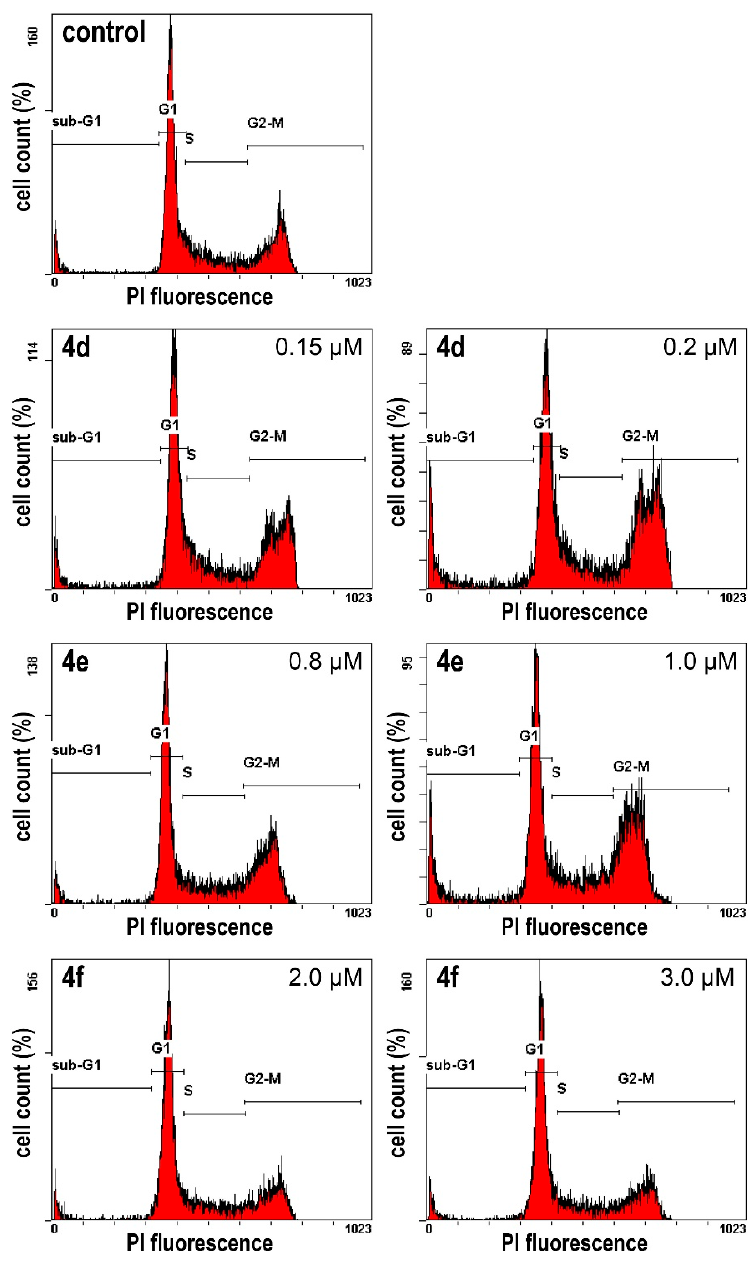
Figure 6. Effect of 4d (0.15 and 0.2 µ M), 4e (0.8 and 1 µ M), 4f (2 and 3 µ M) or control (DMSO) on the proportions of 518A2 melanoma cells in G1, S, and G2/M phase of the cell cycle as well as the percentages of apoptotic cells in sub-G1 as determined by flow cytometry after PI staining. Cells were treated with the test compounds for 24 h. Cell cycle profiles are representatives of at least three independent experiments ( p ≤ 0.05 for cells in G1-phase treated with 4d–f compared with those of vehicle-treated controls, two-tailed Games–Howell’s post-hoc test). Table 3. Effect of 4d–4f on the cell cycle of 518A2 melanoma cells 1.